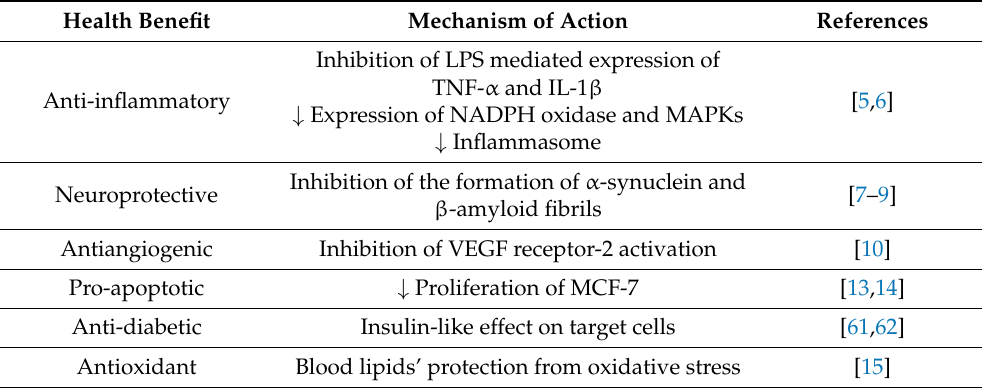
Table 5. Summary of the health benefits and mechanism of action of